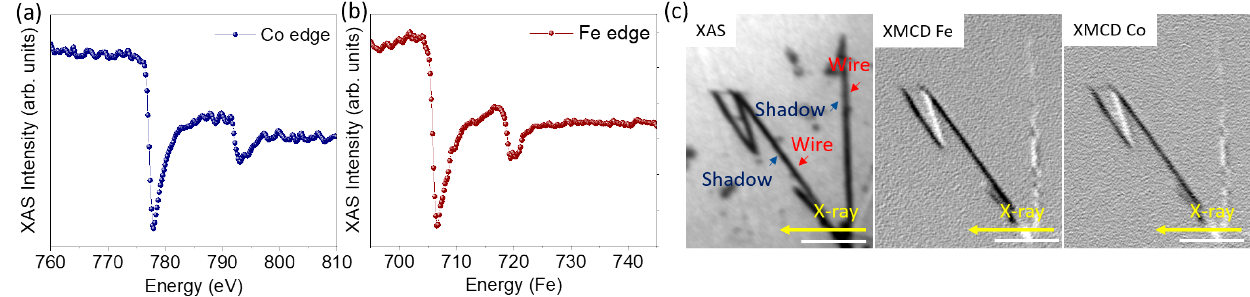
Figure 4. ( a , b ) X-ray absorption spectra of Co and Fe. ( c ) XAS image for CoFe NWs and XMCD image at Fe L 3 and Co L 3 edges for the same wires where it is possible to distinguish magnetic contrast only in the shadow of the wires. The scale bar is 1 µ